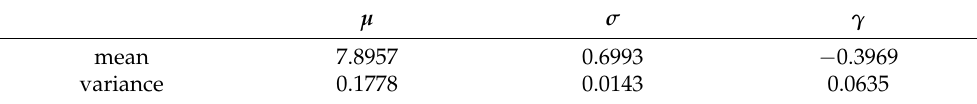
Table 5. Mean and variance for the LP3 parameters estimated from the spatial regression models.